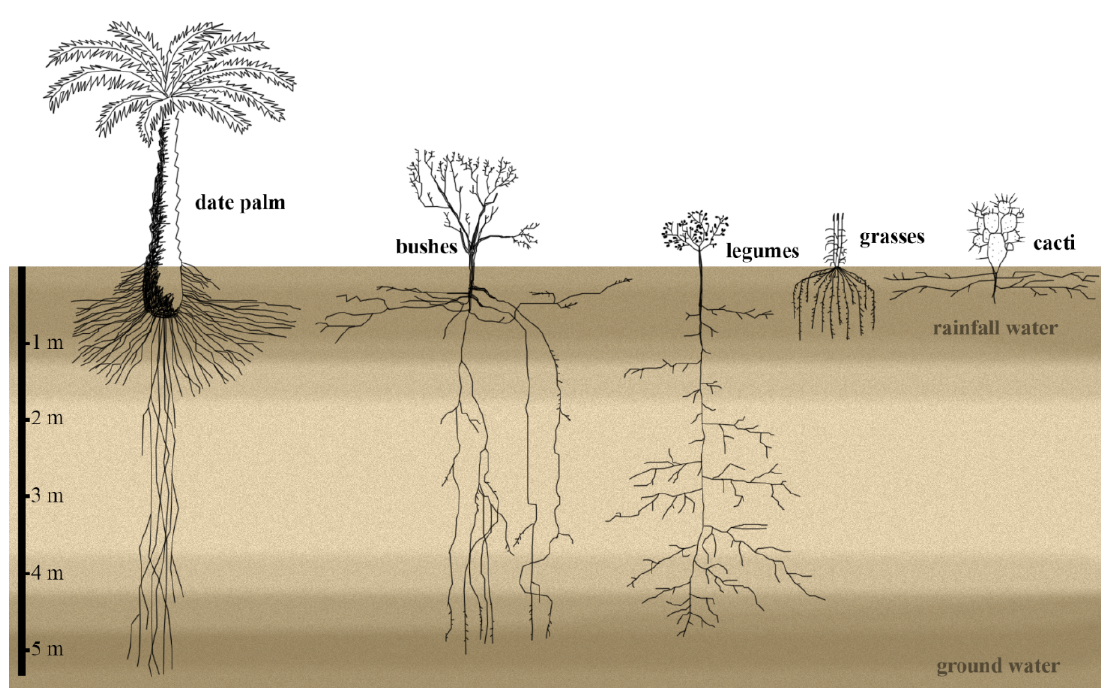
Figure 1. The root system architecture of desert plants exploits the top-soil water reservoir, the deep-soil groundwater, or both. The root system width and shoots size are not according to scale; date palm roots can reach deeper than 5 m [4,7,17–19].